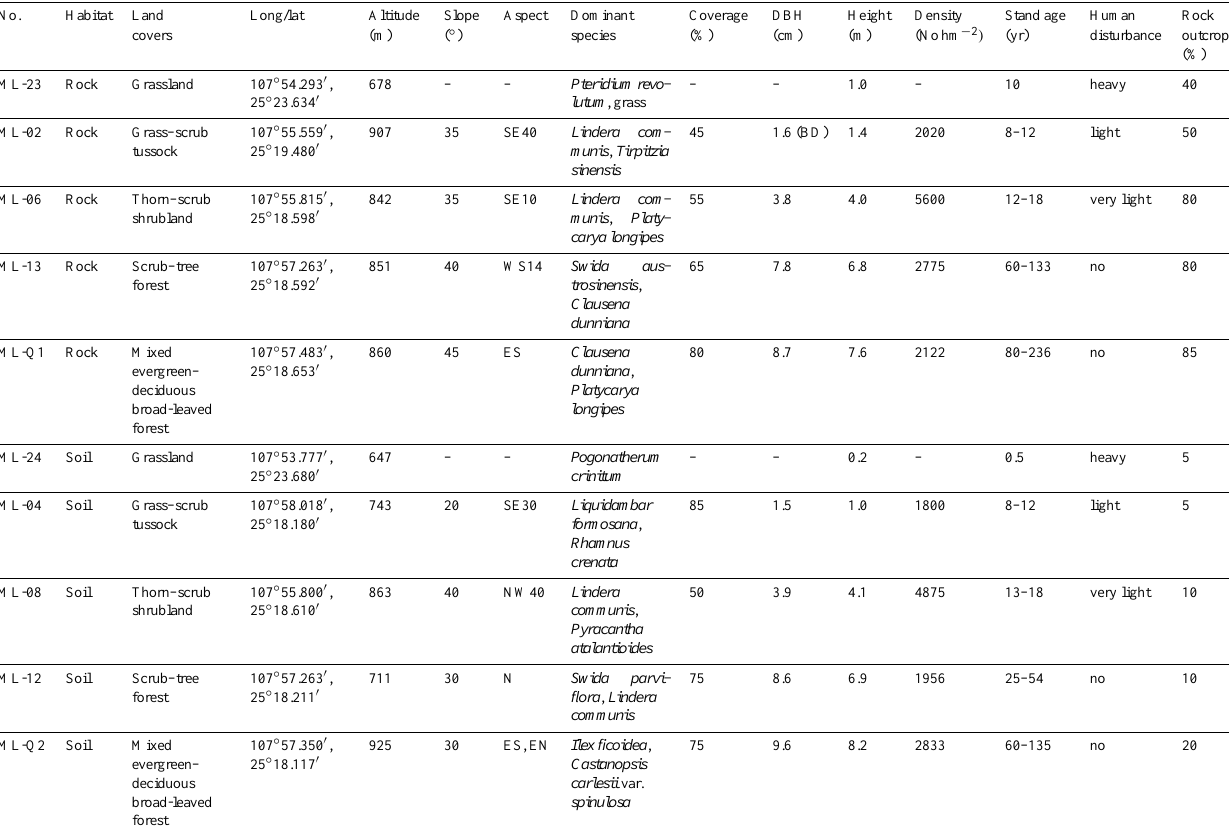
Table 1. Key features of 10 plots for root biomass sampling in Maolan National Natural Reserve, Guizhou province, SW China. No. Habitat